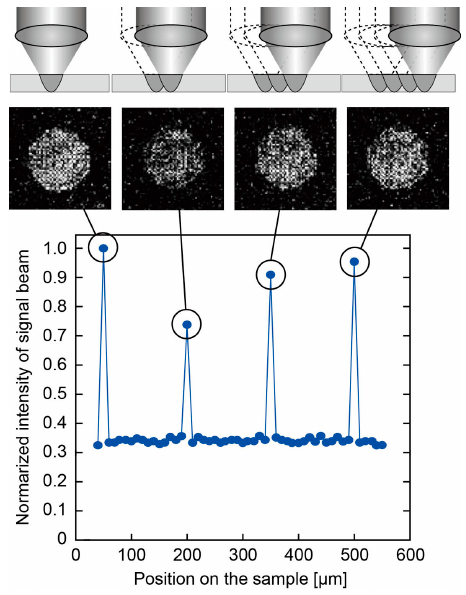
Figure 6. Results of shift multiplex recording of a magnetic collinear hologram showing schematic recording positions of the shift multiplex recording, and the intensity of the signal light and the corresponding reconstructed image plotted against the position on the sample [24].